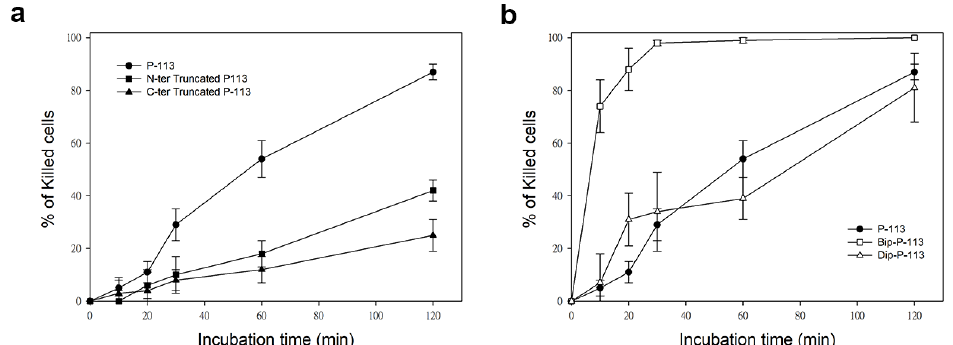
Figure 7. Time killing activity of FITC-labeled P-113 peptide and its FITC-labeled derivatives against Candida albicans . Cells were treated with 1 × MIC of ( a ) P-113 (black circle), FITC-labeled N-terminal truncated P-113 (black square), FITC-labeled C-terminal truncated P-113 (black triangle), and ( b ) treated with FITC-labeled Bip-P-113 (white square), and FITC-labeled Dip-P-113 (white triangle). Killed cells (%) = (cell number in peptide-free control − cell number in sample) / (cell number in peptide-free control) × 100. Error bars represent the standard errors of the mean.